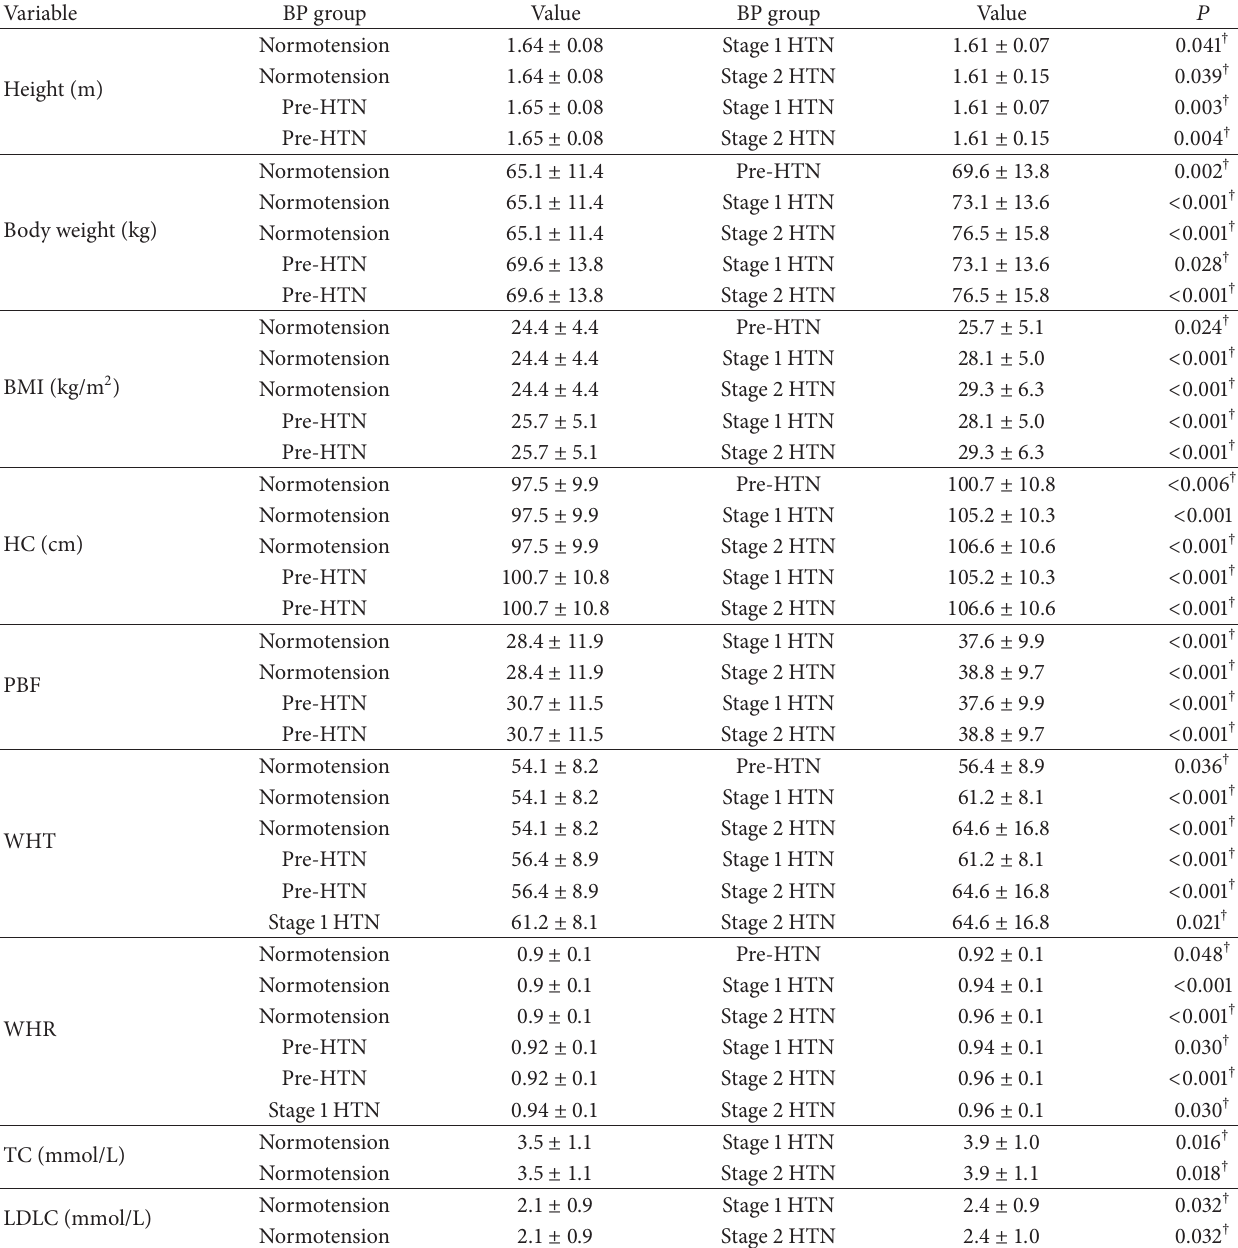
Table 3: Comparison of non-MS components among BP